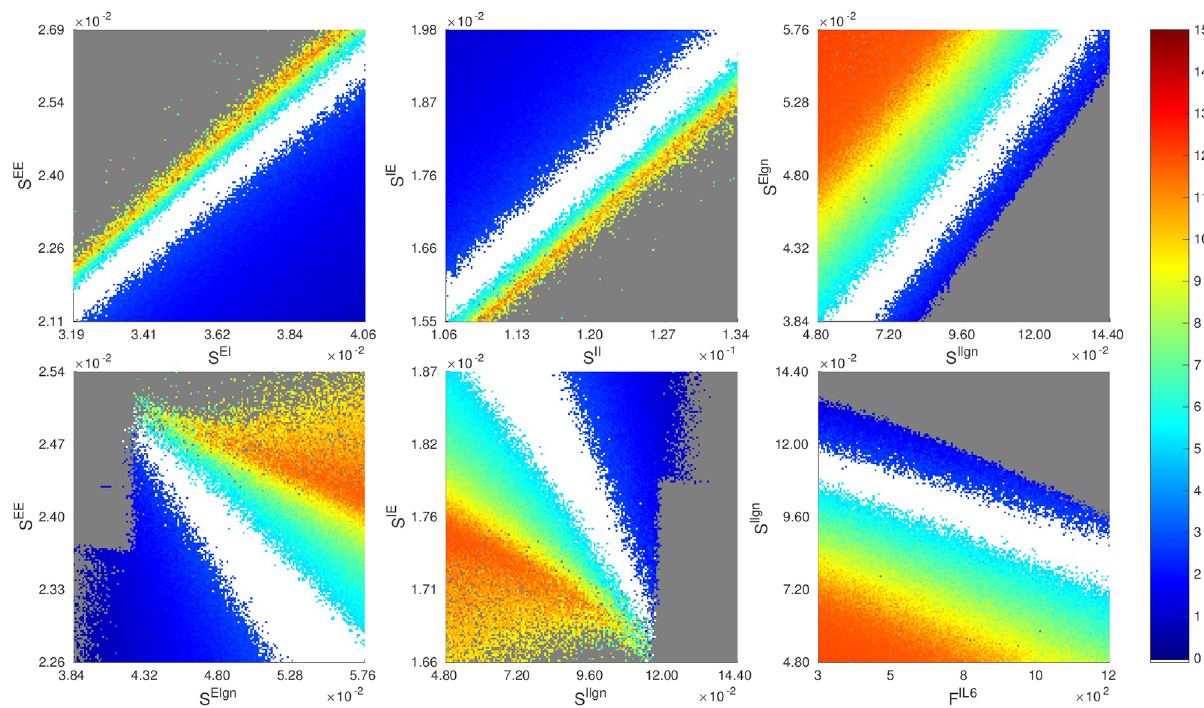
Fig 7. Slicing the 7D parameter space from other directions through the reference point. We compute the rate maps of f E and indicate viable regions on six other 2D slices, namely, the planes of S EE × S EI , S IE × S II , S E lgn × S I lgn , S EE × S E lgn , S IE × S I lgn , and S I lgn × F I L6 . Firing rates are as in the color bar, and as usual the good area is in